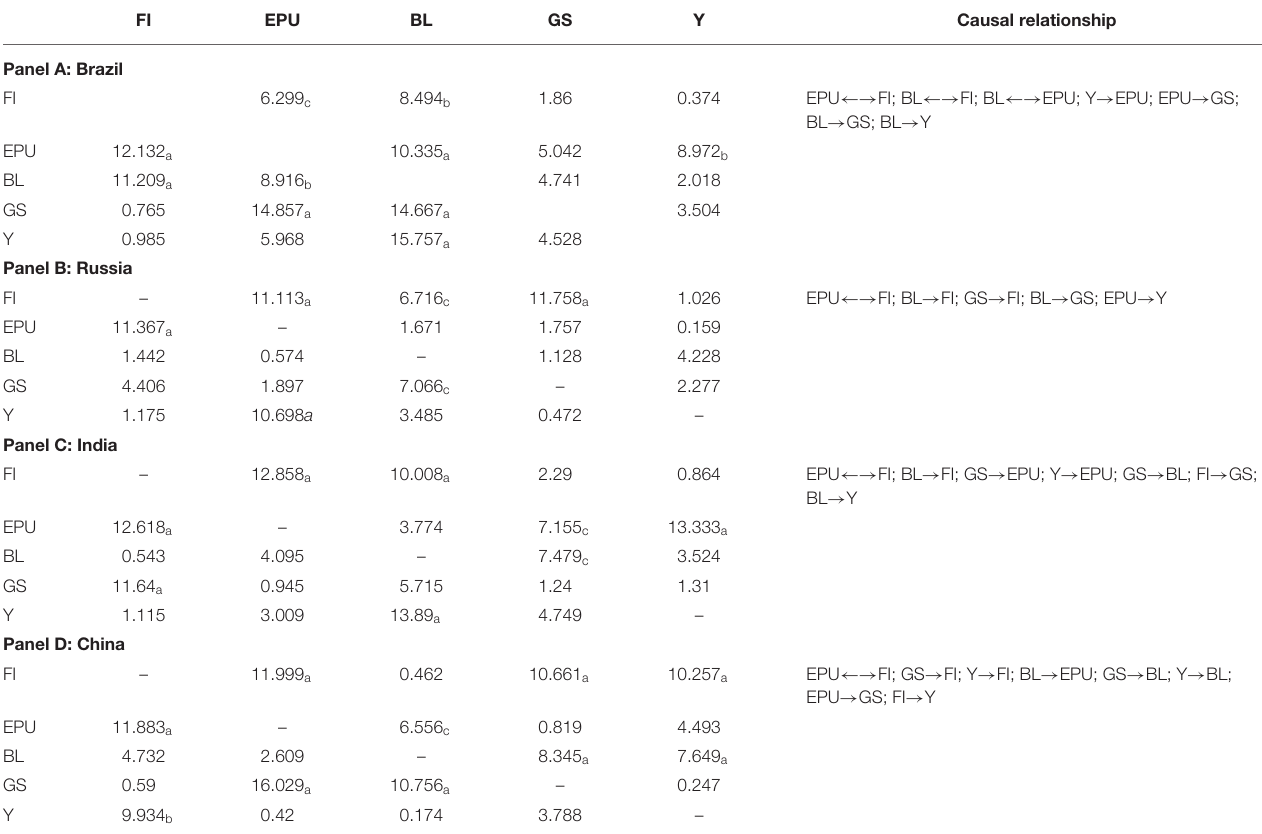
TABLE 8 | Results of causality test: Financial innovation measured by R&D investment by financial institutions. FI EPU BL GS Panel A: Brazil